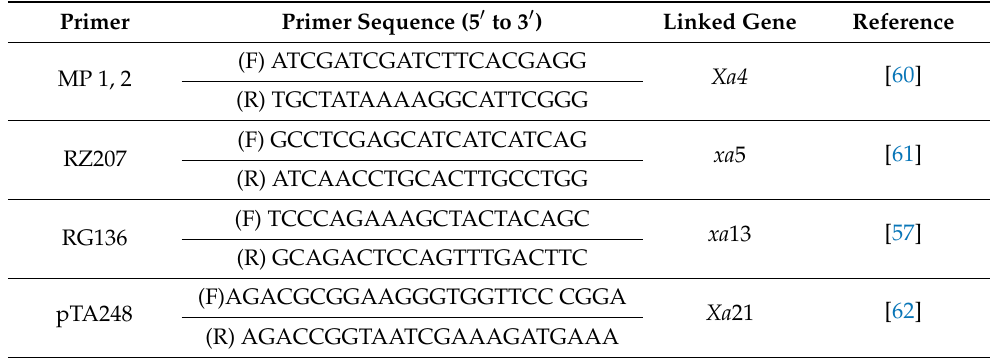
Table 3. Sequence of primers used in this